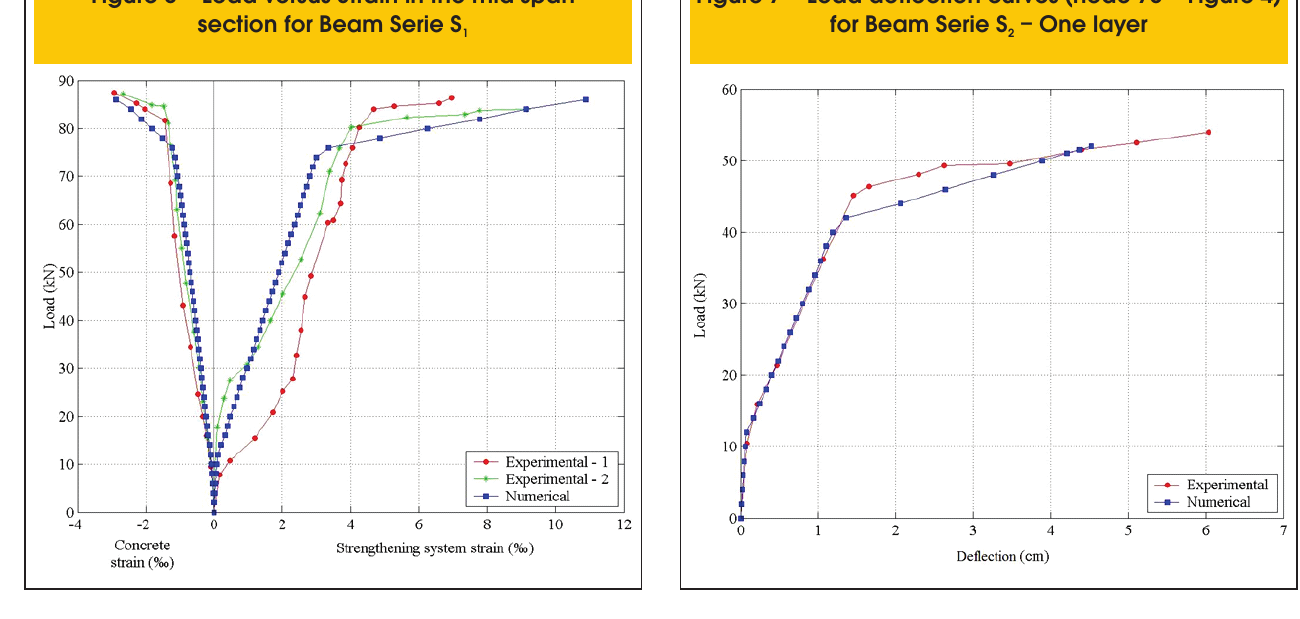
Figure 6 – Load versus Strain in the mid-span Figure 7 – Load-deflection curves (node 73 – Figure 4) section for Beam Serie S for Beam Serie S – One layer 1